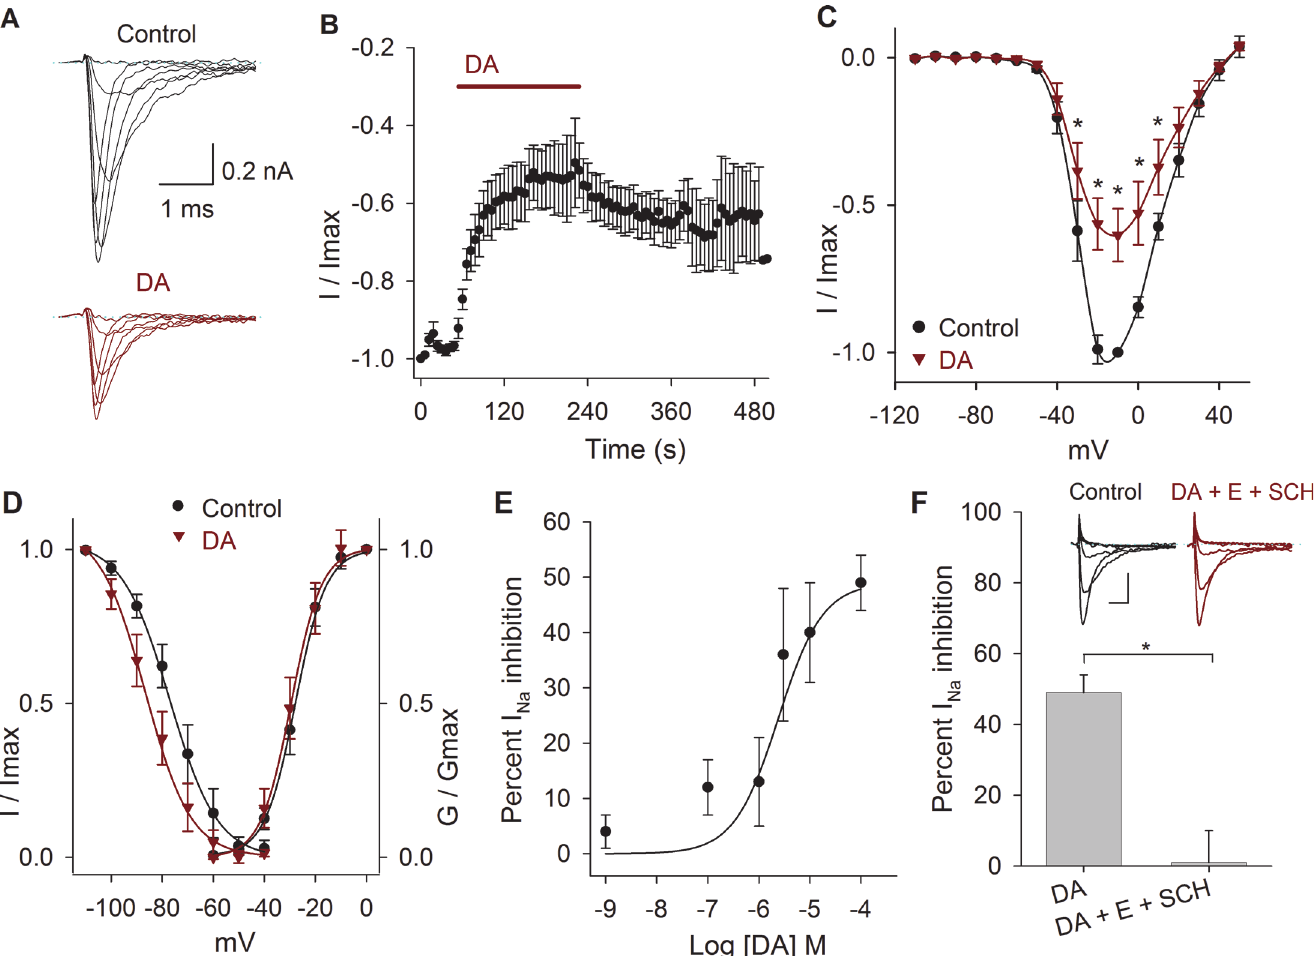
Fig 2. Effects of DA on the I Na . A) Representative experiment showing the effect of 10 μ M DA after control perfusion. B) Temporal course of the inhibitory action of DA 100 μ M on the I Na amplitude. Bar indicates the DA perfusion. C) Current-voltage relationship in control and with 10 μ M DA. DA decreased the I Na by 43 ± 8% at − 20 mV ( P = 0.001; n = 9). D) Activation and inactivation curves in control and after DA application. DA caused a hyperpolarizing shift of the V ½ of the inactivation curve of 8 mV at 10 μ M ( P = 0.8). In this and following activation and inactivation curves the data were fitted with a Boltzmann function (solid lines). E) Concentration-response relationship of the effect of DA (1 nM to 100 μ M), with at least n = 6 for each point. The data were fitted with a concentration response curve (solid line) with an IC 50 of 2.5 x 10 – 6 M and a Hill coefficient of 1. F) Bar graph shows that a mixture of D1 and D2 antagonists (100 μ M